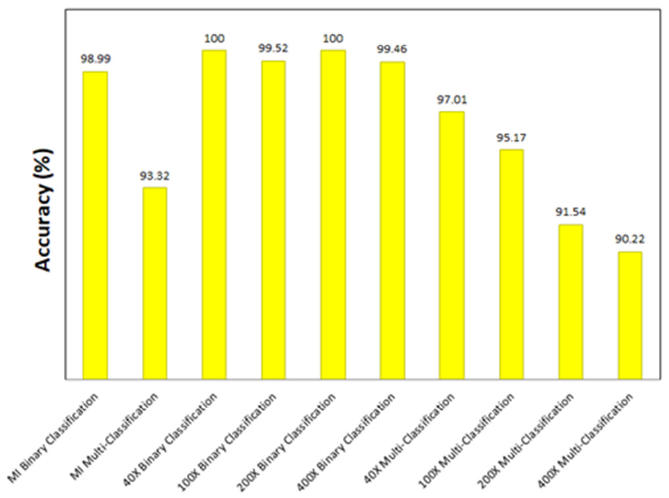
Figure 31. Accuracy achieved by the best model for all the experiments.